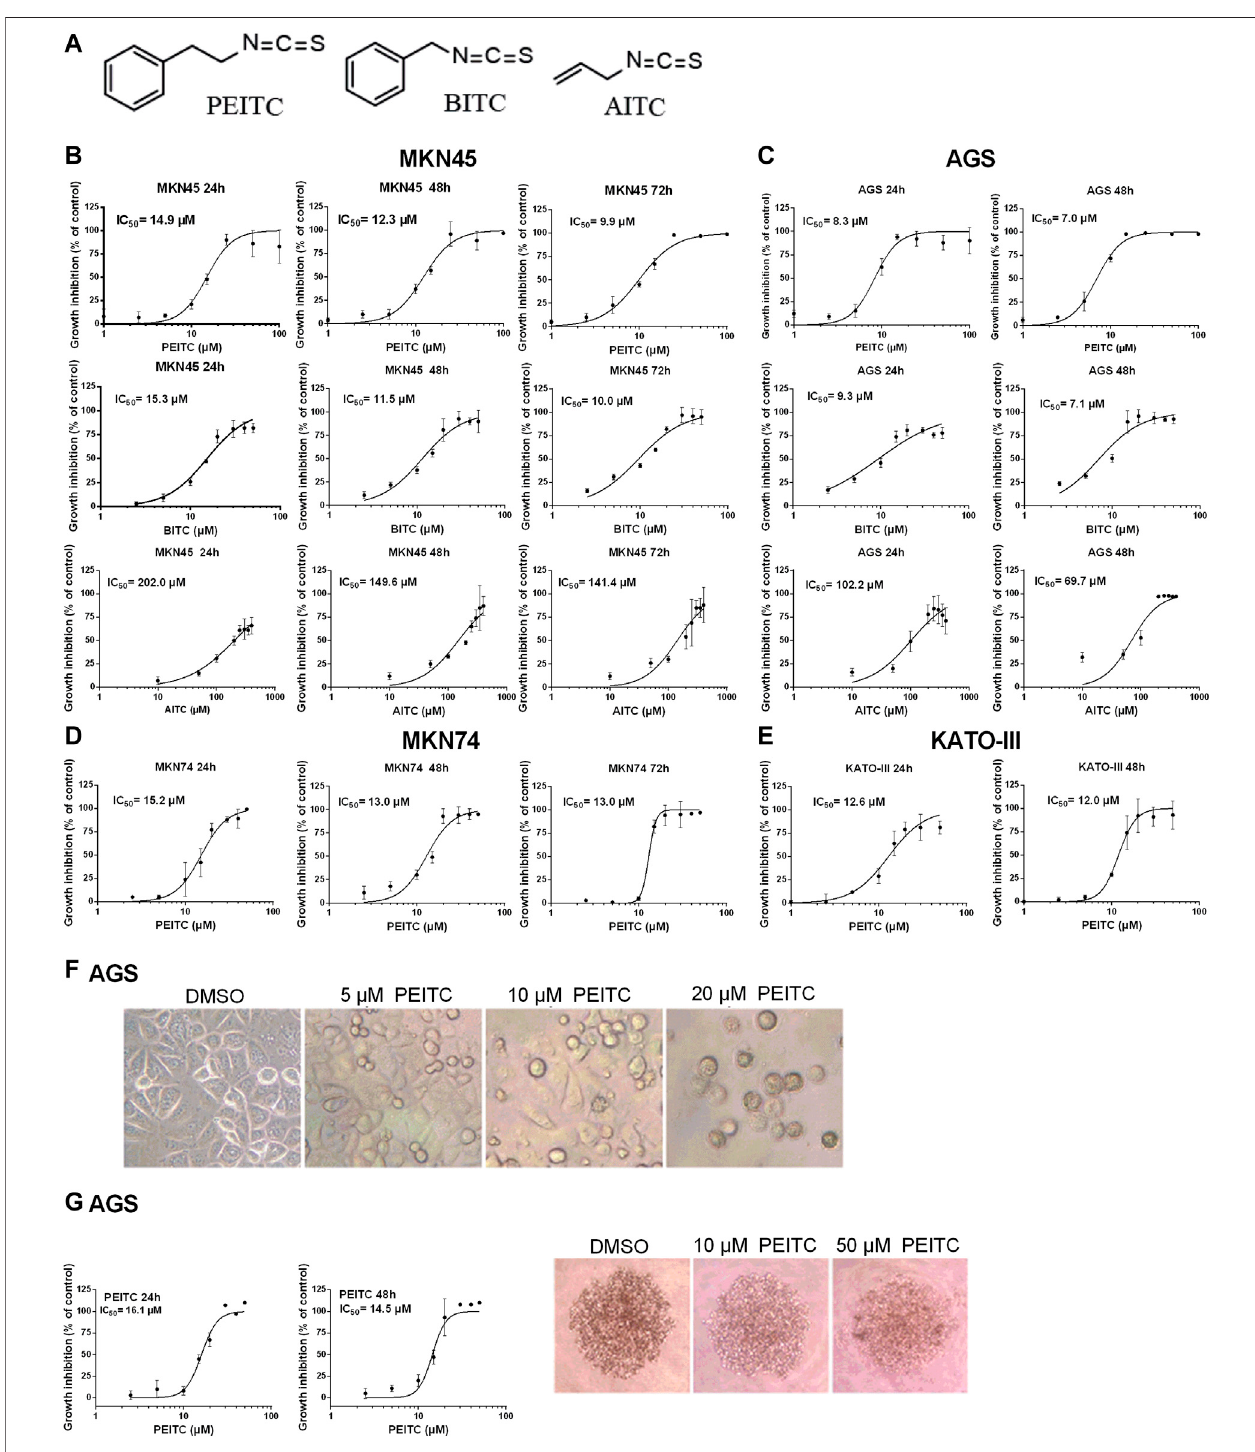
FIGURE 2 | Chemical structures of ITCs (A) and proliferation dose-response curves of gastric cancer cell lines MKN45 (B) and AGS (C) when treated with PEITC (1 – 100 µM), BITC (2.5 – 50 µM) and AITC (10 – 400 µM) for 24, 48 and 72 h in medium containing 1.0 g/L (5.6 mM) glucose and 0.584 g/L (4 mM) glutamine. Values represent means of n (cid:1) 3 – 6 replicates relative to vehicle control (0.1% DMSO), and IC 50 values were calculated from the logistic sigmoidal regression curves shown. Standard deviation (SD) values were omitted from cultures with 98% or higher inhibited growth as these yielded non-representatively high SD values. Proliferation dose-response curves of gastric cancer cell lines MKN74 and KATO-III when treated with PEITC (1 – 50 µM) (D, E) . Morphology of AGS cells affected by ITC-treatments (F) .Proliferationandmorphologyofspheroid3DculturesofAGScellstreatedwithPEITCfor24 – 48 h (G) .PEITC,phenethylisothiocyanate;BITC,benzylisothiocyanate; AITC, allyl isothiocyanate; DMSO, dimethylsulfoxide.